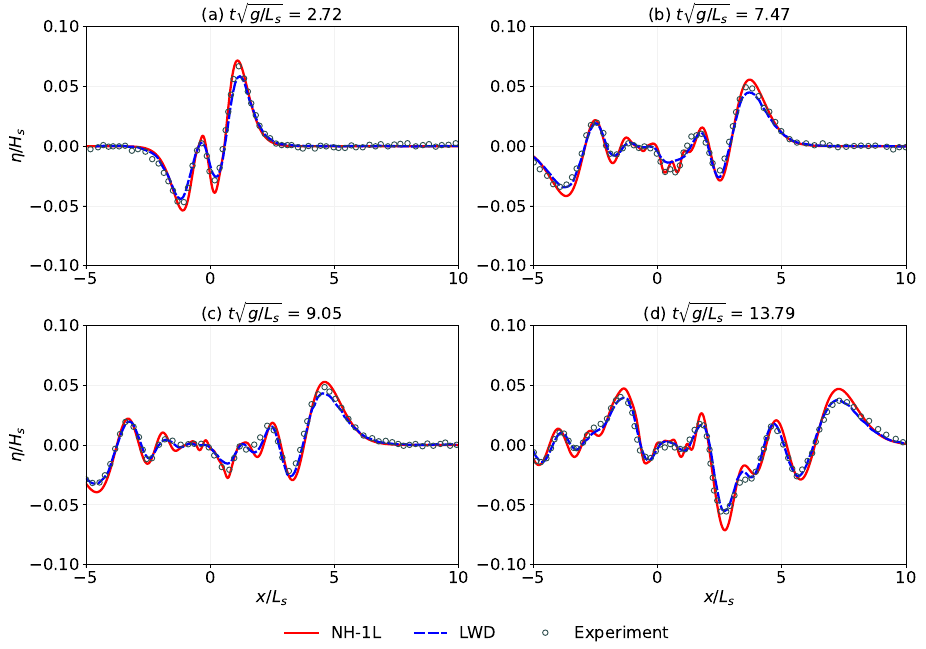
Figure 10. Wave profiles at subsequent times from run 21; results of the NH-1L model are compared with the LWD and experimental